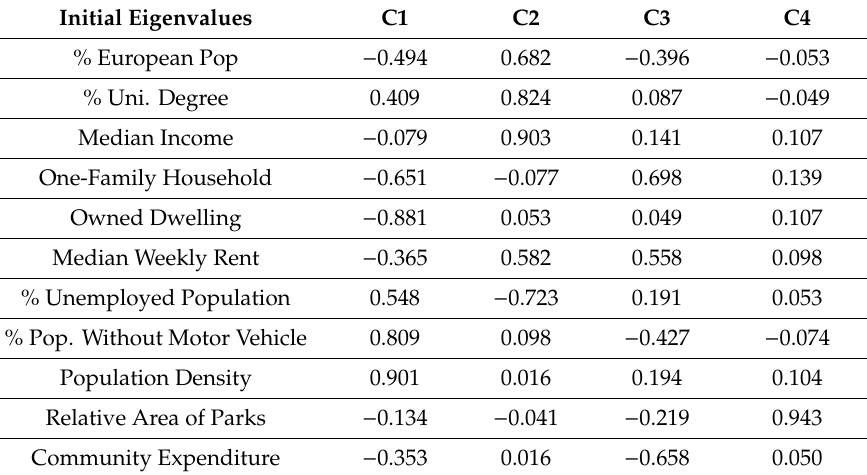
Table 4. The four extracted components (C1 through C4) and the variable